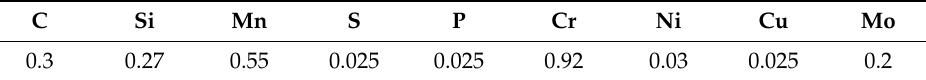
Table 1. Chemical composition of 30CrMoA steel (wt.%).